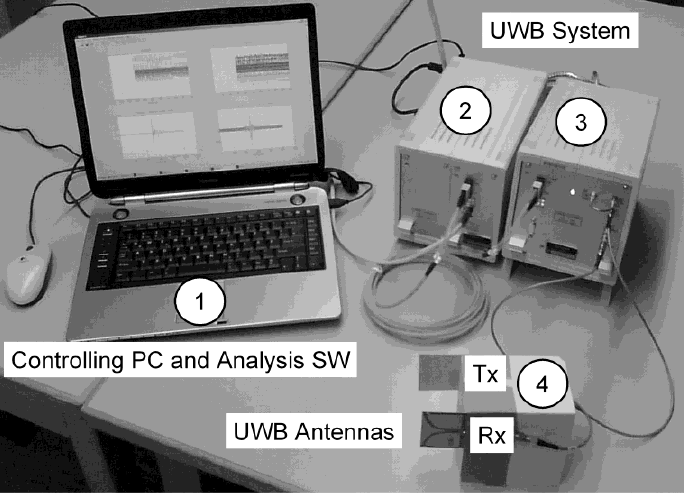
Figure 1. Prototype of our MR-compatible UWB system (MEODAT, Ilmenau), designed according to the Medical Device Directive, in a basic set-up for ultra-wideband measurements. (1) : Controlling PC and analysis software. ( 2) : Galvanic